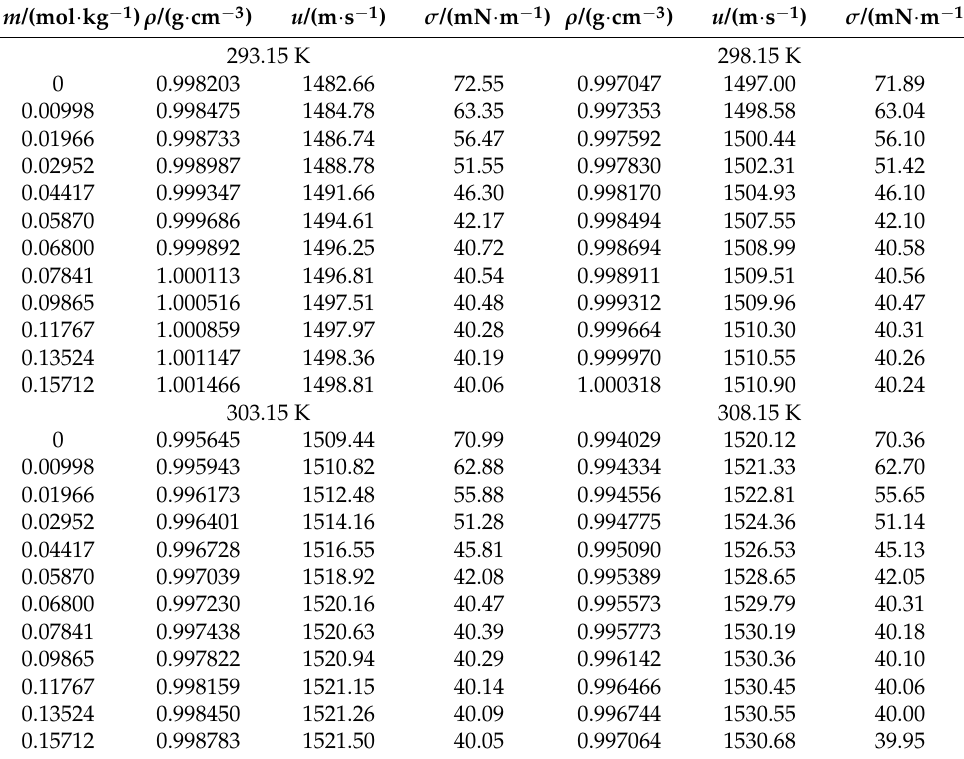
Table 1. Density, sound velocity, and surface tension of decyltrimethylammonium bromide (C 10 TAB) in water at temperatures between T = 293.15 K and 308.15 K at 75